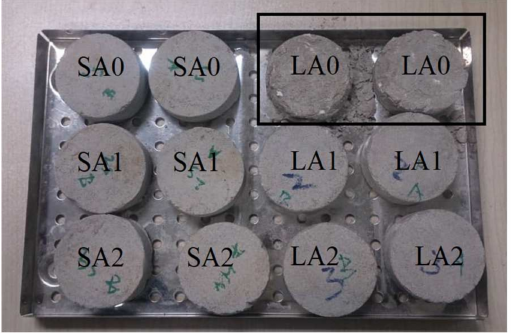
Figure 7. Lower soundness and superficial durability of LA0 compared to the other samples after 5 freezing–thawing